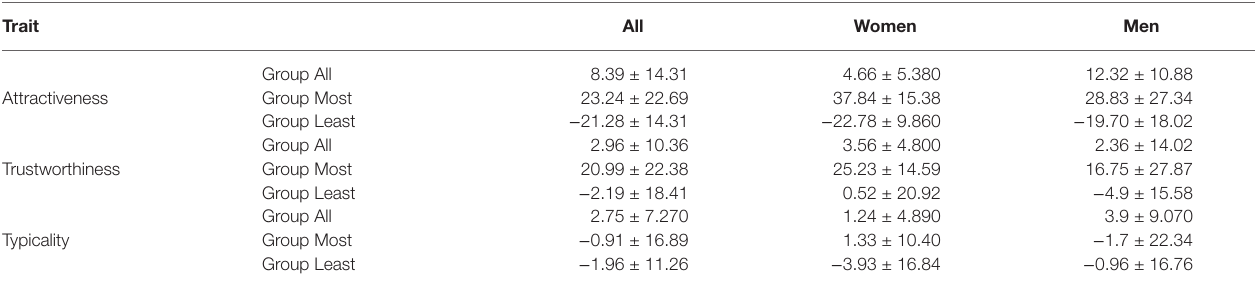
TABLE 3 | Descriptive statistics of the predicted DFT for peaks in trait judgments based on Gaussian curve fitting in each participant’s data ( M ± SD ). Trait